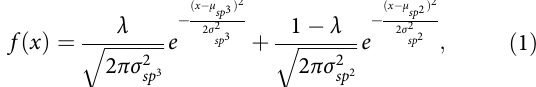
d CCC angle distributions for